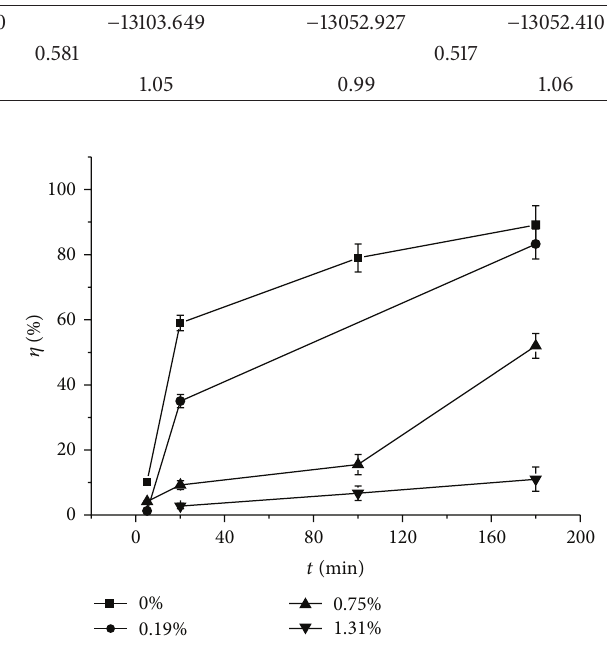
Figure 3: Relationships between the embrittlement index and hydrogen charging time of the four different aluminium contents of bainitic steels at a strain rate of 5.6 × 10 −5 s −1